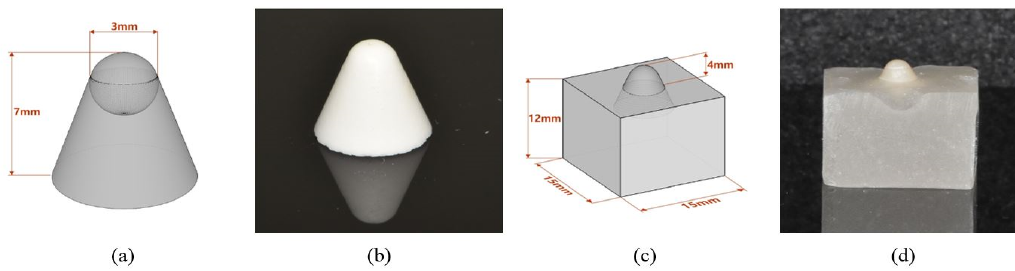
Figure 2. Schematic drawing of a restorative material specimen. ( a) Standardized design for a restorative material specimen. ( b ) Steatite specimen fabricated by the CAD-CAM system. ( c , d ) Specimens embedded in auto-polymerizing acrylic resin.